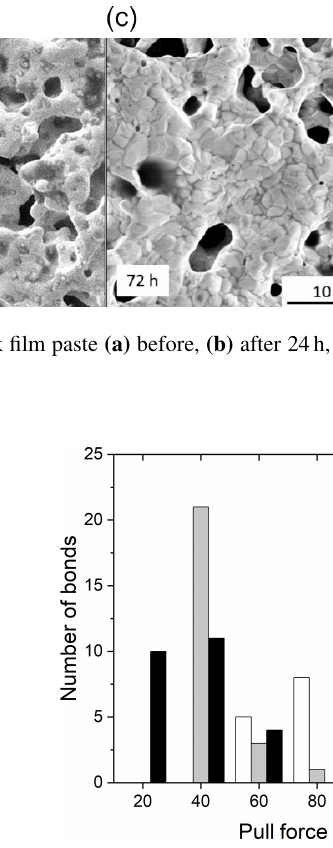
Figure 9. Bond strength distribution on thin film platinum layer on sapphire. As bonded and after thermal ageing of the bond on thin film for 6h at 800 and 1000 ◦